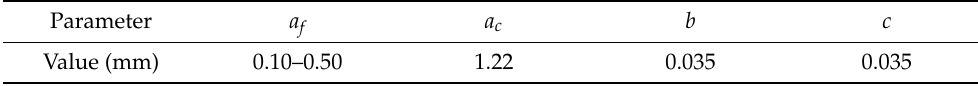
Figure 9. Double ellipsoidal heat source of the welding process. Table 3. Parameters of the heat source.